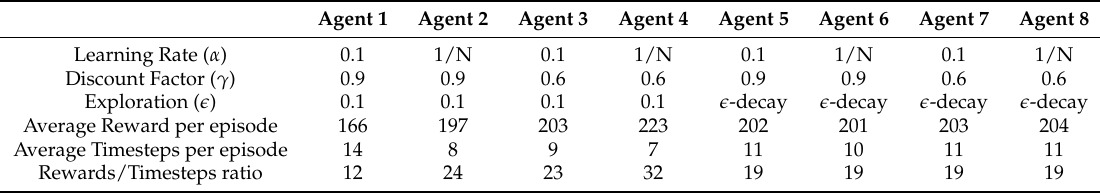
Table 2. Performance of 8 agents with different hyperparameter values after 100,000 epochs training using Reward shaping